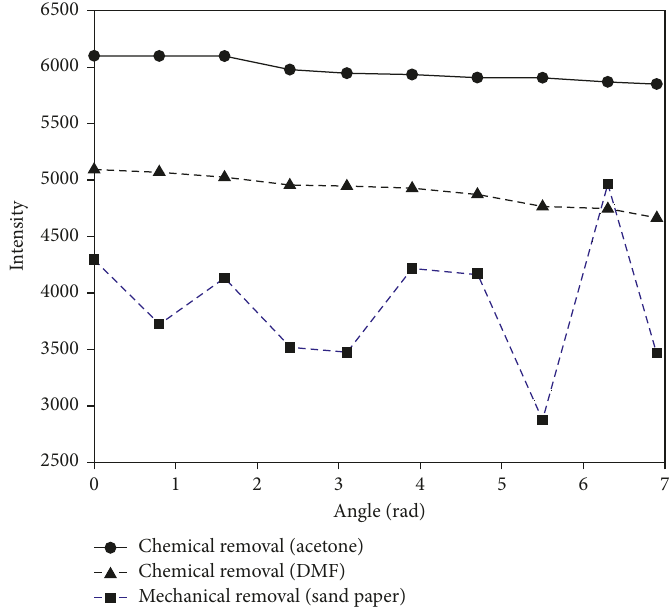
Figure 17: Radial distribution of maximum side-illumination of PGR-FB250 specimen after chemical and mechanical